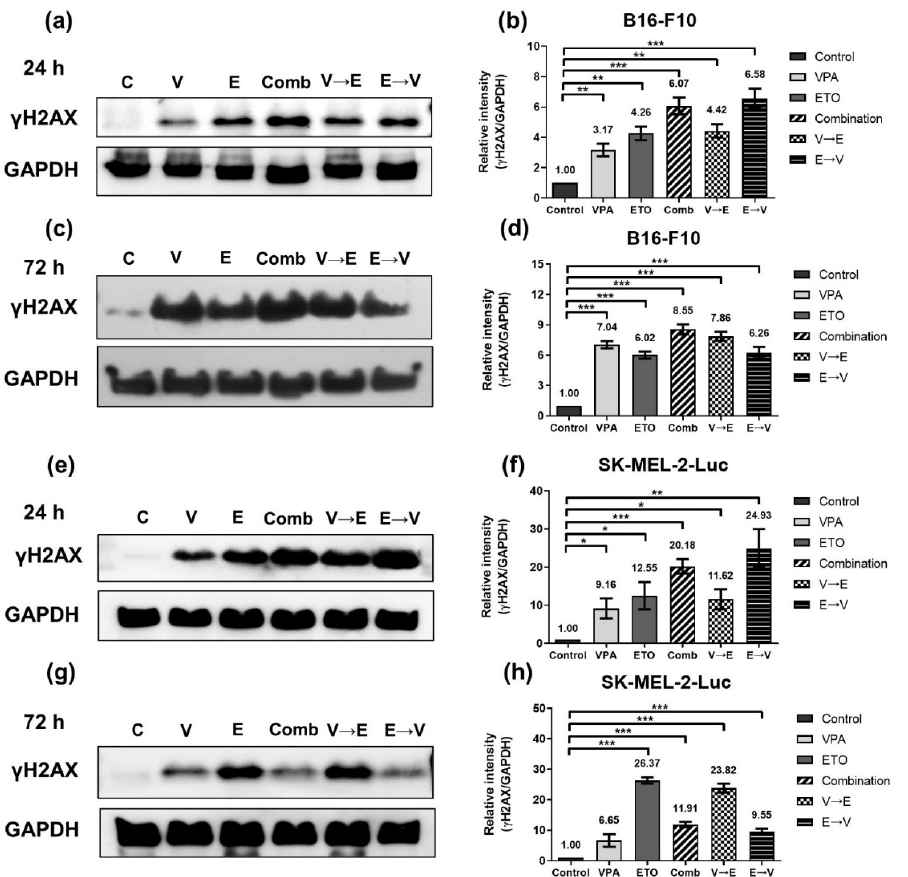
Figure 6. DNA damage induced by single, simultaneous, and sequential combined treatments of VPA and ETO in melanoma cells. Western blot analysis illustrated the DNA damage induced γ H2AX expression after ( a ) 24 h ( c ) 72 h single, simultaneous, and sequential combined treatments of VPA and ETO in B16-F10 cells. ( b , d ) Quantitative analysis of ( a , c ) was obtained by using Image J software 1.52a (National Institutes of Health, Bethesda, MD, USA) and normalized with the no treatment control. The analysis was repeated in SK-MEL-2-Luc cells. Western blot data of ( e ) 24 h and ( g ) 72 h was shown, and the corresponding quantitative analysis was shown in ( f , h ), respectively. GAPDH was used as the control of sample loading. Relative intensities of γ H2AX to GAPDH expressions were normalized with the control. The data are shown as means ± SEM of independent experiments in triplicate. (* p < 0.05; ** p < 0.01; *** p < 0.001). The drug dosages were referred to IC 50 values as shown in Figure 2 and Table 1.